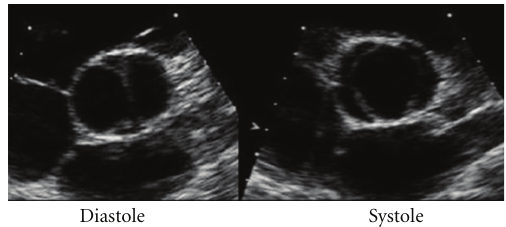
Figure 3: The bicuspid valve in the parasternal short axis